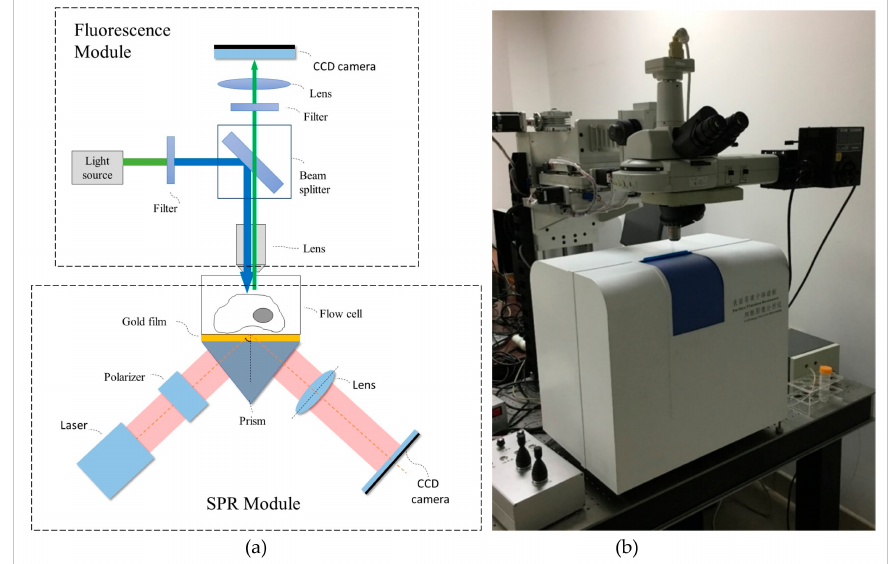
Figure 1. Optical structure ( a ) and photograph ( b ) of the surface plasmon resonance (SPR) and fluorescence synchronous detection system.